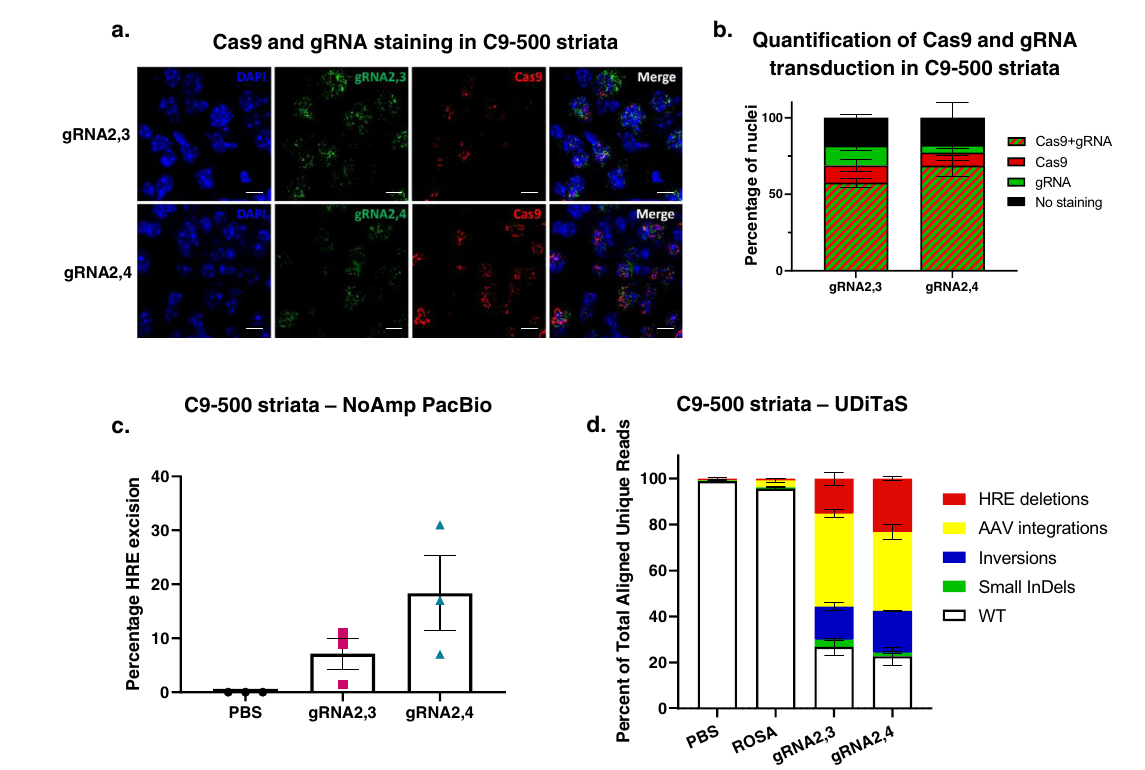
AAV9-gRNA2,4-treated C9-500 mice. c Percentage of reads in which the HRE is excisedafter gRN2,3and gRNA2,4 editing in C9-500 striatalDNA measured by No- Amp PacBio. Mean±SEM, n =3 per group. d Composition of edited alleles at